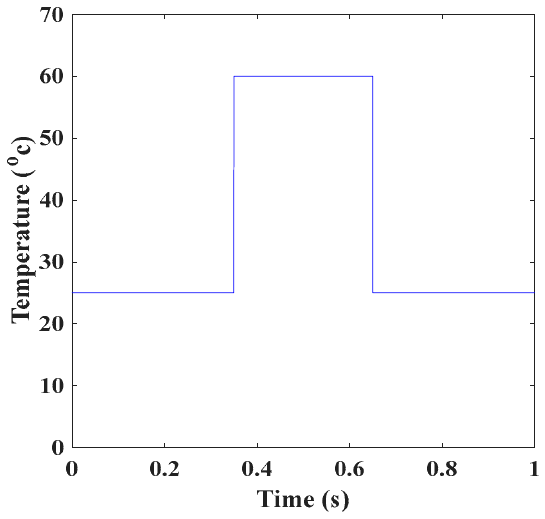
Figure 10. Sudden temperature change at 1000 W/m 2 . With the same value of irradiation (1000 W/m 2 ), the temperature was initially at 25 ◦ C and then it suddenly increased to 60 ◦ C at t = 0.35 s; then, at 0.65 s, a drop in temperature from 60 ◦ C to 25 ◦ C was applied abruptly; eventually, the temperature was kept steady at 25 ◦ C until the simulation time ended at 1 s. In the MSX60 solar cell test, as seen in Figure 11a, first, before 0.35 s, the algorithms completed the STC case as analyzed herein. At 0.35 s, when temperature increased to 60 ◦ C, P&O and INC algorithms could track the MPP, with identical reactions in 362 ms with 53.88 W output power, with an approximate error of 12 ms. Furthermore, both modified algorithms converged to a higher MPP of 54.22 W and responded faster than the classical methods, with a similar response time of 356.5 ms and a slight error of 6.5 ms. Moreover, with negligible steady-state oscillations, the updated algorithms can also detect the abrupt drop in temperature that occurred at 0.65 s with a 7.5 ms error and a minor reduction in the power (60.18 W) relative to P&O and INC (60.48 W) in 656.5